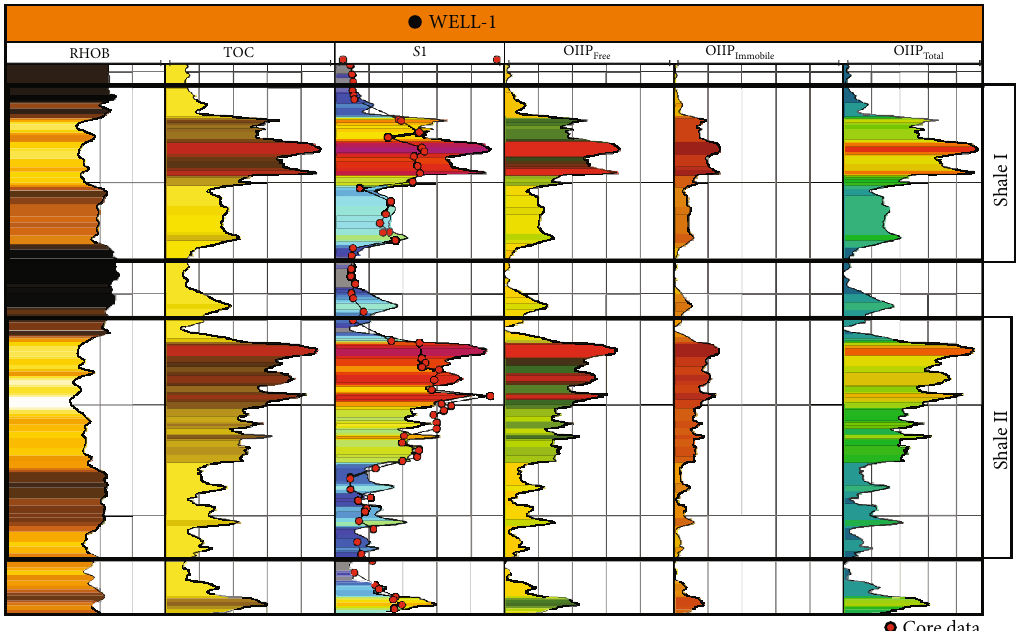
Figure 8: Exemplary results of oil-in-place estimation using Rock Eval-based geochemical method along one of the boreholes: on the fi rst three tracks input data were posted — accordingly — bulk density, TOC, and S 1 parameter. Tracks 3-6 present vertical pro fi les of OIIP Free , OIIP OIIP Immobile , and Total which is a sum of the previous